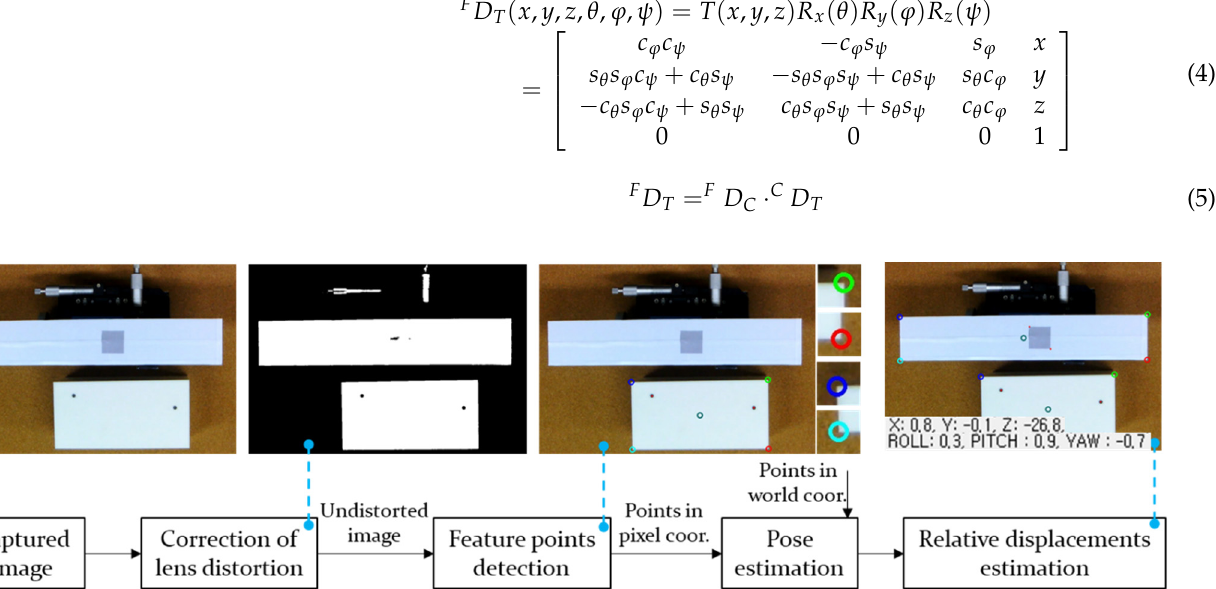
Figure 3. A block diagram of the displacement estimation process.